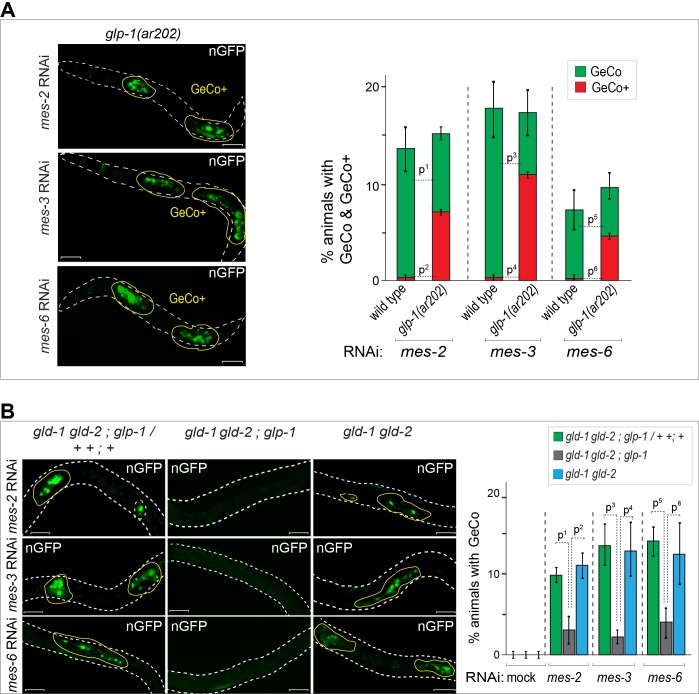
GLP-1Notch enhances reprograming upon the depletion of PRC2.(A) Notch and PRC2 genetically interact in GeCo. Left: Fluorescent micrographs of glp-1(ar202) gain-of-function mutants expressing CHE-1–induced neuronal GFP. The animals were subjected to control RNAi or RNAi against PRC2 components (MES-2, 3, and 6), as indicated. Increased GLP-1Notch signaling enhanced the GeCo+ phenotype upon PRC2 depletion. Control RNAi (mock) for each genetic background did not result in any GeCo (images not shown – see quantification). Right: The corresponding quantifications. P-values were calculated using Student's t-test: p1=0,0006; p2<0,0001; p3=0,0536; p4=0,0001; p5=0,4035; p6=0,0003. At least 200 animals were scored per condition. Error bars represent SEM. (B) GLP-1Notch is required for GeCo in PRC2-depleted animals independently from proliferation. Left: Fluorescent micrographs of adults expressing CHE-1–induced nGFP, with the genotypes indicated above the panels. The animals were subjected to RNAi as indicated on the left. The first column shows heterozygous, the other two homozygous animals carrying the loss of function alleles gld-1(q497), gld-2(q485) and, in the central panels, glp-1(q175). The animals were subjected to control RNAi or RNAi against PRC2 components (MES-2, 3, and 6). In the absence of GLP-1Notch, depletion of PRC2 components did not induce GeCo. Scale bars = 10 μm. Right: The corresponding quantifications. P-values were calculated using Student's t-test: p1<0,0456; p2=0,0337; p3=0,0070; p4=0,0637; p5=0,0080; p6=0,1259. At least 70 animals were scored per condition. Error bars represent SEM.DOI:
http://dx.doi.org/10.7554/eLife.15477.01410.7554/eLife.15477.015Figure 3—source data 1.Quantification of GeCo upon PRC2 depletion.(A) Quantification of GeCo+ phenotype upon RNAi against PRC2 subunits in glp-1(ar202) mutants. (B) Quantification of GeCo in different genetic backgrounds with highly proliferative germlines upon RNAi against PRC2 subunits. More details can be found in the corresponding figure legends.